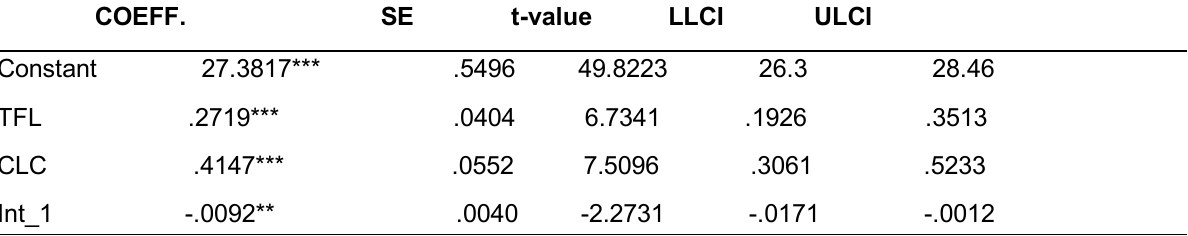
Table 8: Model summary outcomes/Employee creative performance